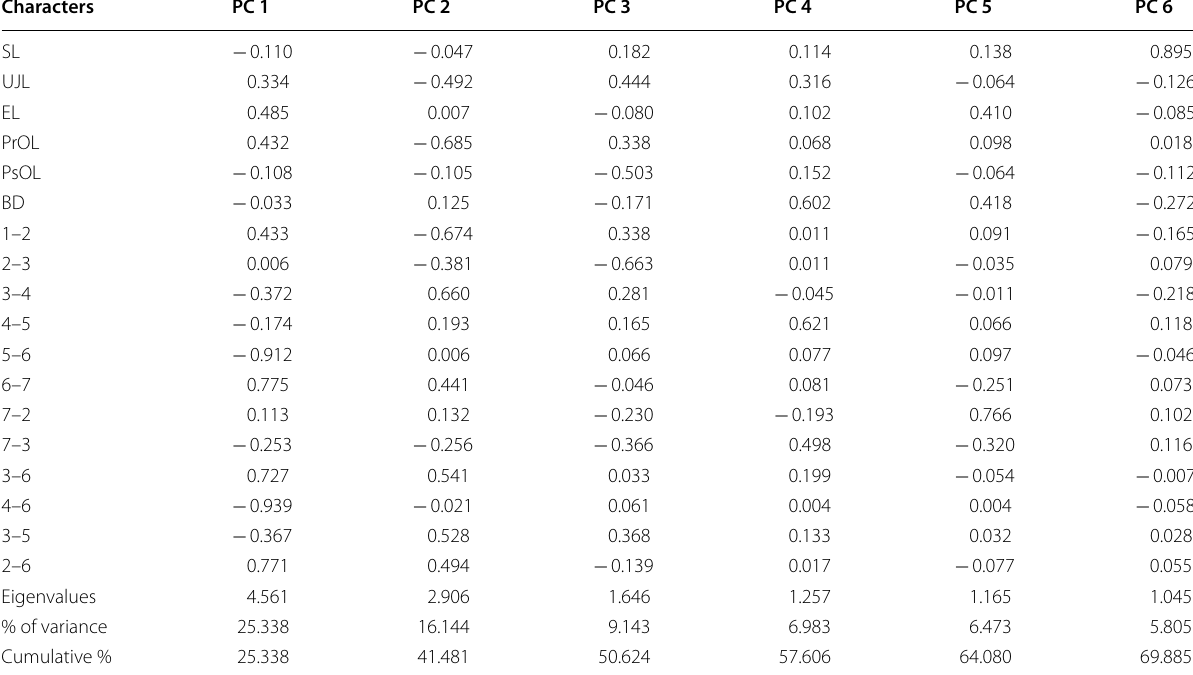
Table 5 Factor extraction in PCA after Varimax normalized rotation on conventional and truss measurements in H. Limbatus